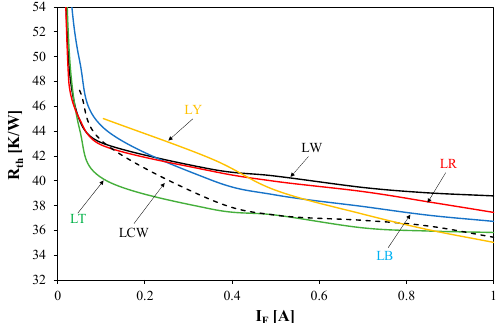
Figure 9. Measured dependences of thermal resistance of the tested diodes on forward current.